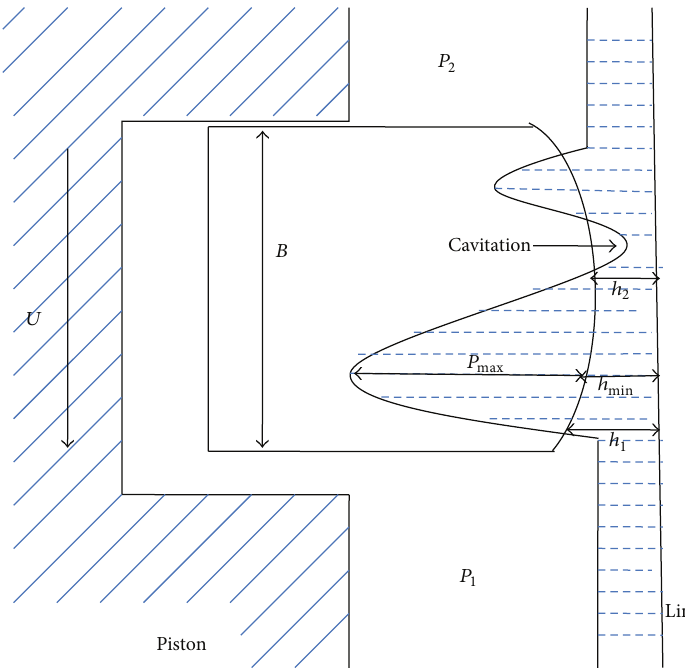
Figure 2: Schematic of hydrodynamic oil film between liner and